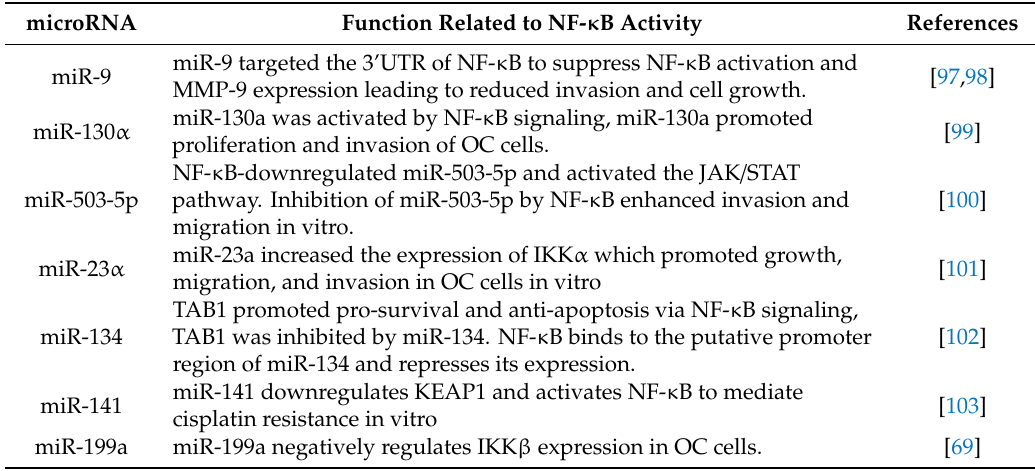
Table 1. miRNAs related to OC progression and NF- κ